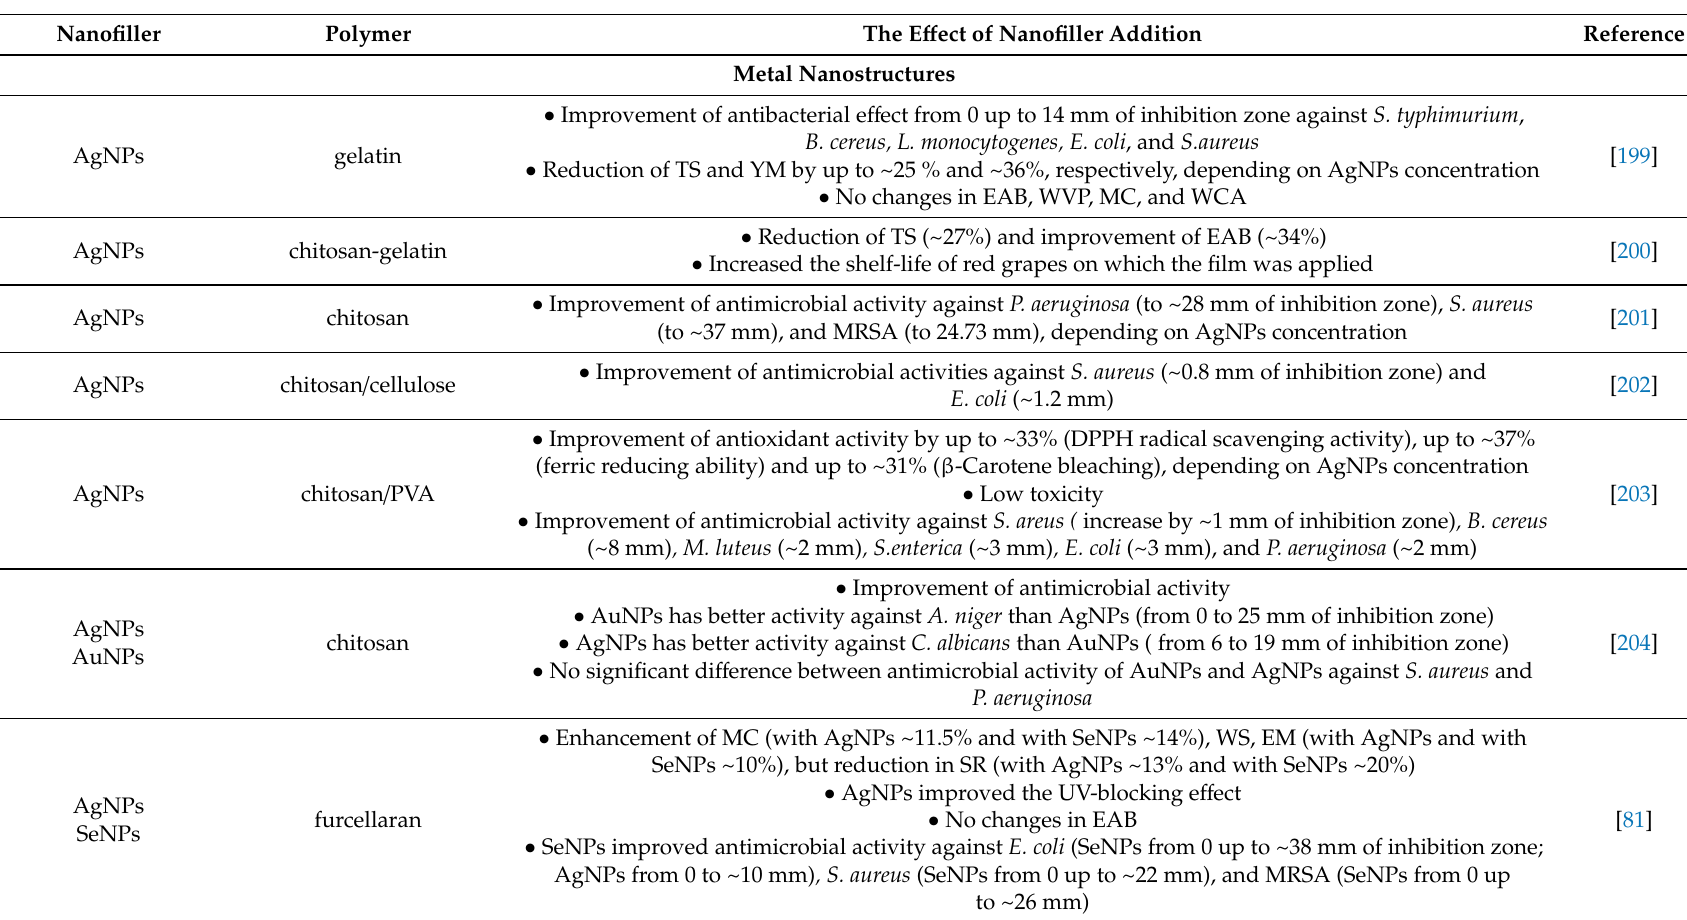
Table 3. Recent examples of nanocomposite